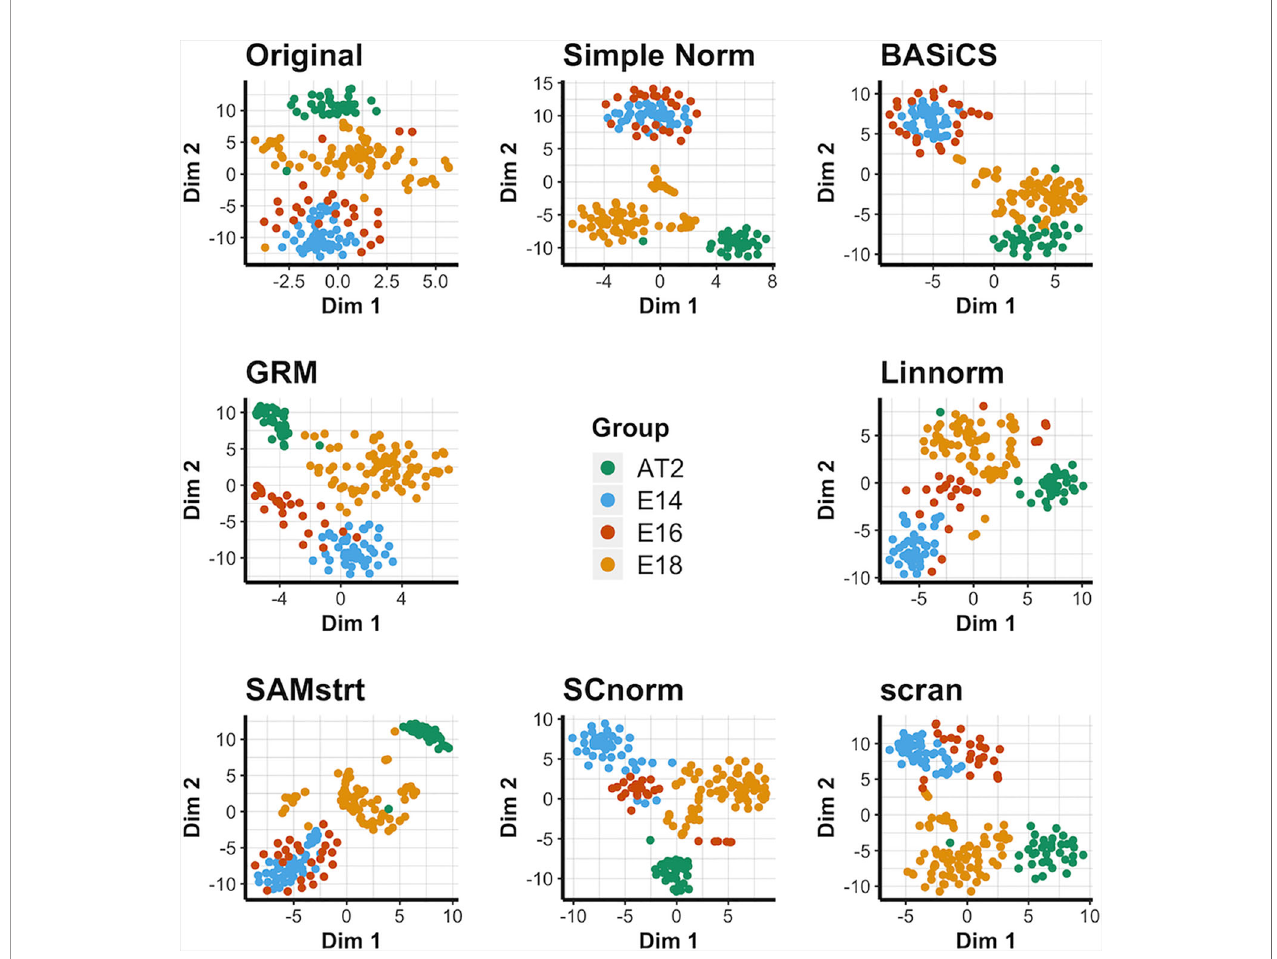
FIGURE 2 | t-SNE plots for the mouse lung data set under various normalization methods, with the original data for